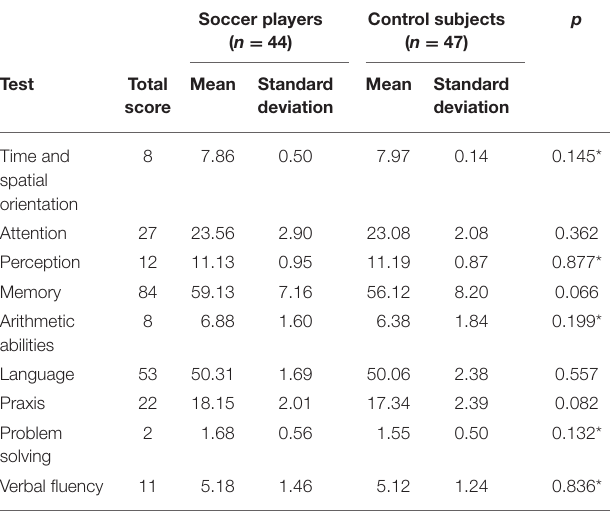
TABLE 1 | Comparison between soccer players and control subjects on computerized cognitive assessment.